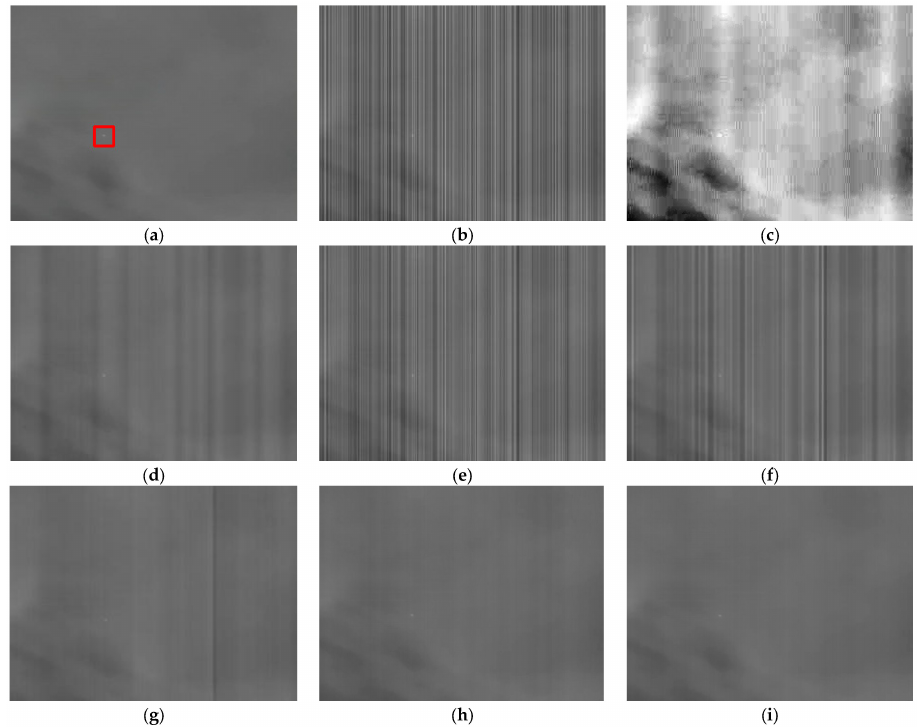
Figure 12. The nonuniformity correction results of Test-1: ( a ) the real, clean infrared dim small target image ( B var = 19), the dim small target is located in the middle of the red box we manually marked; ( b ) infrared dim small target image with nonuniform noise added; ( c ) MHE; ( d ) 1D-GF; ( e ) SNRCNN; ( f ) ICSRN; ( g ) DLS-NUC; ( h ) SNRWDNN; ( i ) ours.